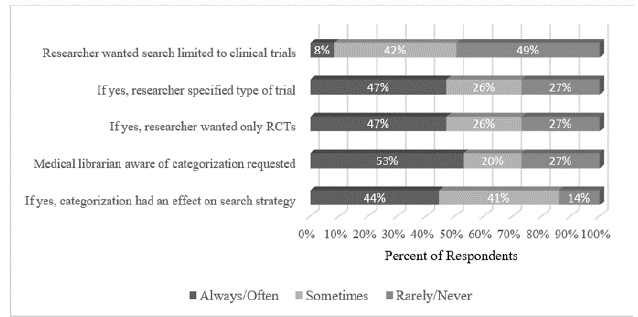
Figure 1 Researchers’ input on search strategy